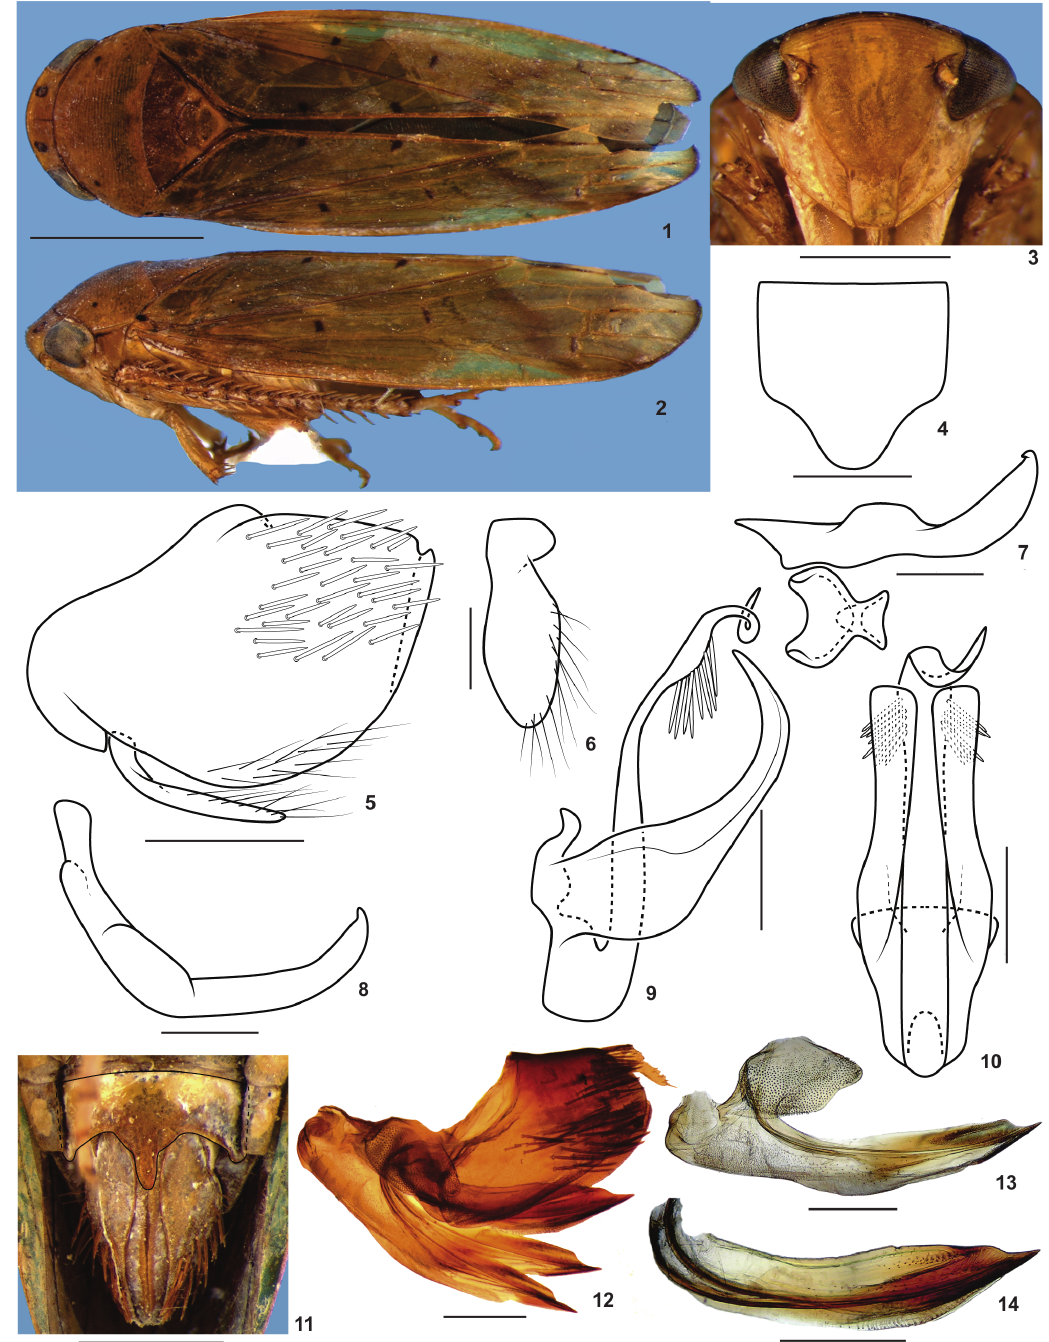
view; (4–10) male terminalia: (4) sternite VIII, ventral view; (5) pygofer and subgenital plate, lateral view; (6) subgenital plate, ventral view; (7) style and connective, dorsal view; (8) style, lateral view; (9) aedeagus, lateral view; (10) aedeagus posterior view; (11–14) Paratype female: (11) apical portion of abdomen, ventral view; (12) genital capsule, lateral view; (13) first valvifer and first valvula, lateral view; (14) second valvulae, lateral view. Scale bars: 1–2 = 2.0 mm, 3, 11 = 1.0 mm, 4–5, 12–14 = 0.5 mm, 6–10 = 0.25